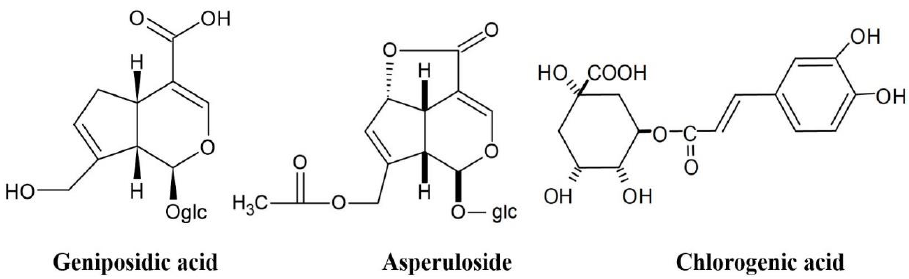
Figure 1. Chemical structures of the main components of ELE.